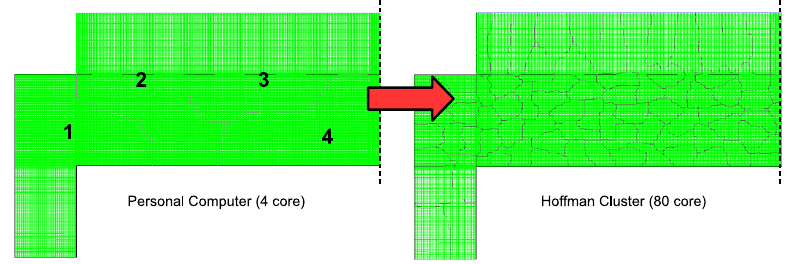
Figure 13. Mesh partitioning using a typical workstation ( left ) and the Hoffman2 cluster ( right